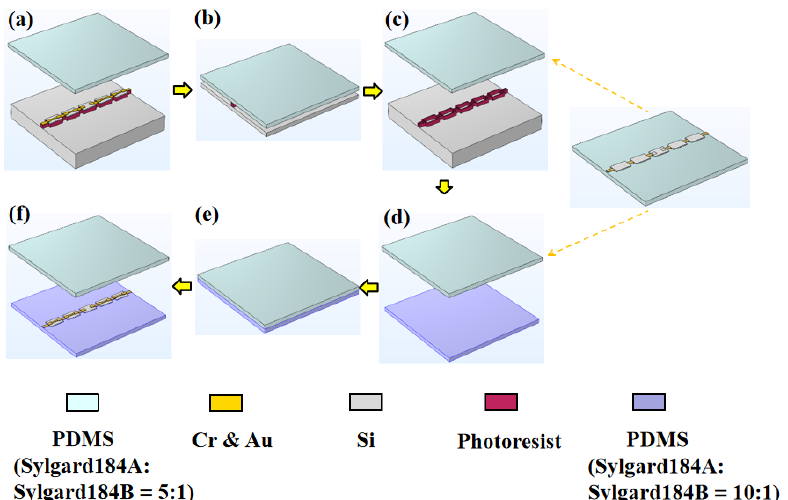
(Figure 2e). It was then peeled off gently, and the silicon nanomembrane was transferred to the PDMS with the ratio of 10:1 (Figure 2f). After the secondary transfer, the specimen was examined again under a confocal microscope to confirm that the sample was intact.